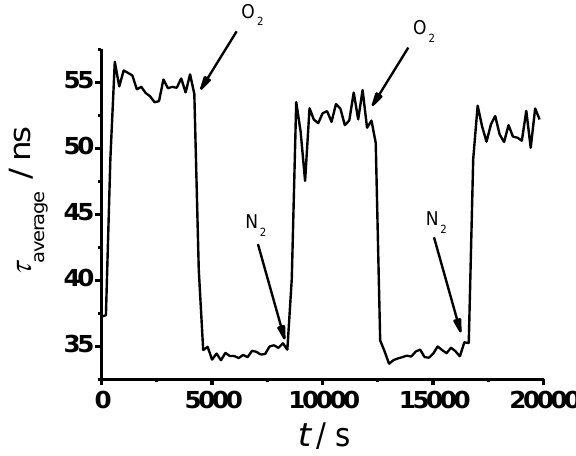
Figure 5. Time response of TP in